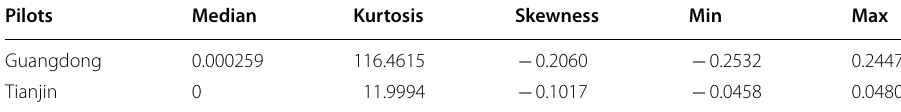
Table 2 Overall estimates of the logarithmic returns to carbon-trading prices